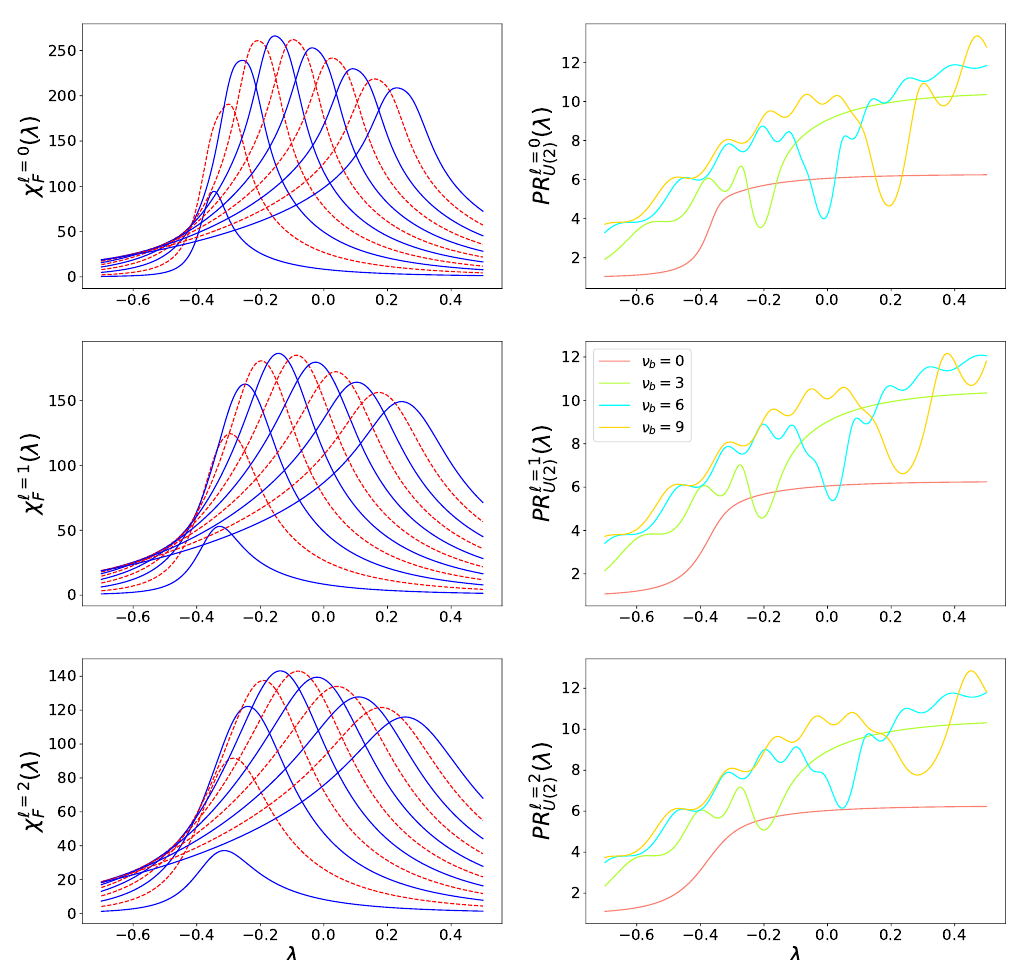
Figure 3: All panels: Results for the optimized eigenstates of the bending degree of freedom of Si C. The upper, middle, and lower rows show results for (cid:96) = 0,1,2, 2 = 0,1,...,10 as a function of the respectively. Left panels: QFS for states with ν b λ control parameter. Full blue lines alternate with dashed red lines for an easier distinction between adjacent states. Right panels: Participation ratio versus the λ = 0,3,6, and control parameter for selected Si C bending states ( ν b 2